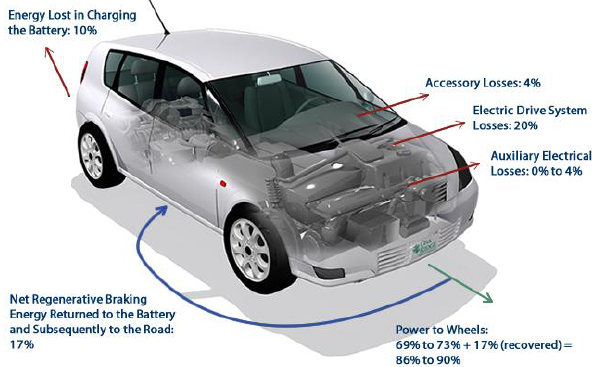
Fig. 2 Electric car energy requirements for combined City/Highway driving